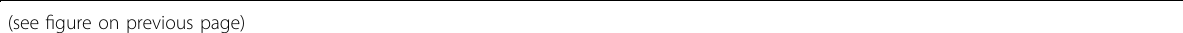
Fig. 3 Pharmacological inhibition of farnesyl diphosphate synthase (FDPS) suppresses glioblastoma sphere formation. a Abbreviated representation of cholesterol synthesis. Black, metabolite; red, key enzymes; blue, FDA-approved drugs that inhibit the indicated enzymes. b , c Alendronate inhibited glioblastoma sphere formation. Patient-derived glioblastoma sphere cells (TS13-20 and TS13-18) were treated with the indicated concentrations of drugs for 7 days. Bright fi eld images of cells were taken with a Cytation 3 microplate reader (Bio-Tek, Winooski, VT, USA). b A representative image of the experiment is shown. c Intact and damaged spheres were quanti fi ed ( n = 3). *** P < 0.001, ** P < 0.01, * P < 0.05, and NS P > 0.05 relative to the number of spheres cultured under no-drug-treatment conditions. d Limiting dilution assays were performed in TS13-20 and TS13-18 cells treated with the indicated concentration of alendronate. e Damaged spheres did not form secondary spheres. TSs cultured for 7 days were treated with or without alendronate for 7 days. Then, all sphere cells (intact and damaged) were subjected to secondary sphere formation. Bright fi eld images of cells were taken 7 days after secondary culture using Cytation 3; a representative image of at least three